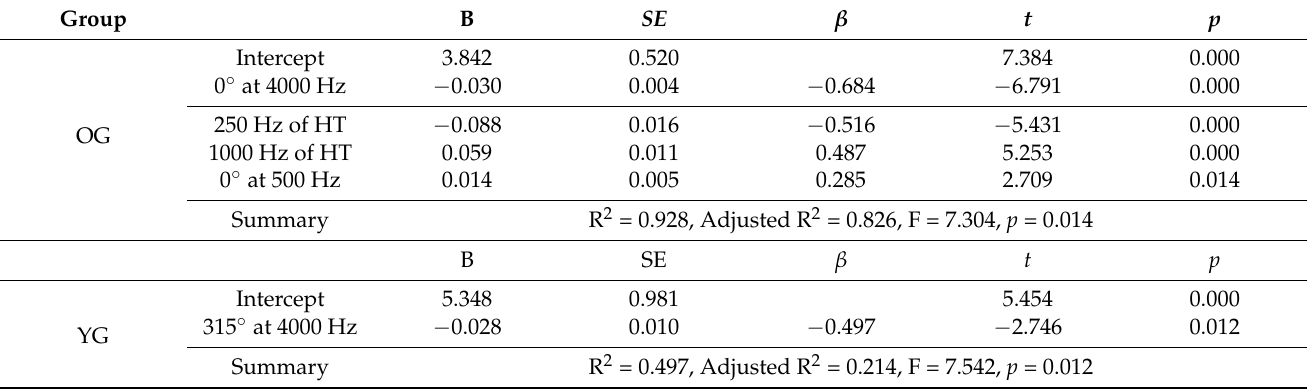
Table 4. Summary of the multiple regression analysis for listening effort and tone detection task for both groups. Group